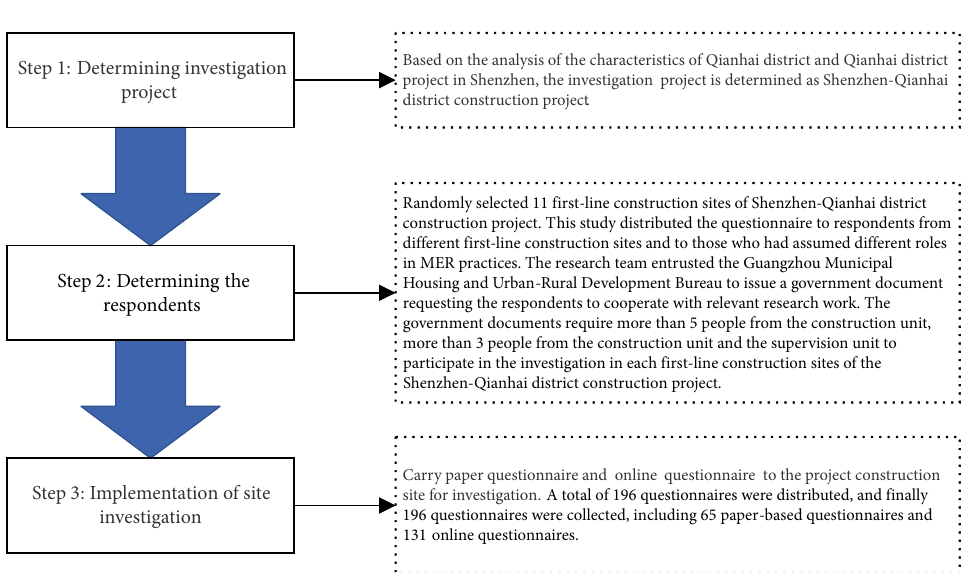
Figure 2. Survey